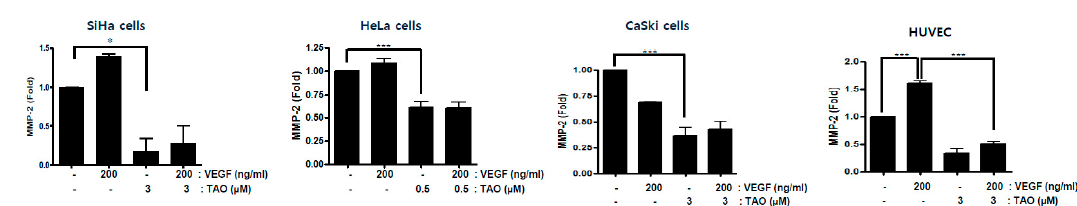
Figure 2. The concentrations of MMP-2 by enzyme-linked immunosorbent assay (ELISA). The treatment of TAO significantly decreased the concentrations of MMP-2 in all cervical cancer cell lines and HUVECs. The co-administration of vascular endothelial growth factor (VEGF) and TAO did not change the inhibitory effects of TAO on MMP-2, whereas the treatment of VEGF only mildly increased the concentrations of MMP-2 in SiHa and HeLa cell lines and HUVECs. * p -value < 0.05, *** p -value < 0.001.